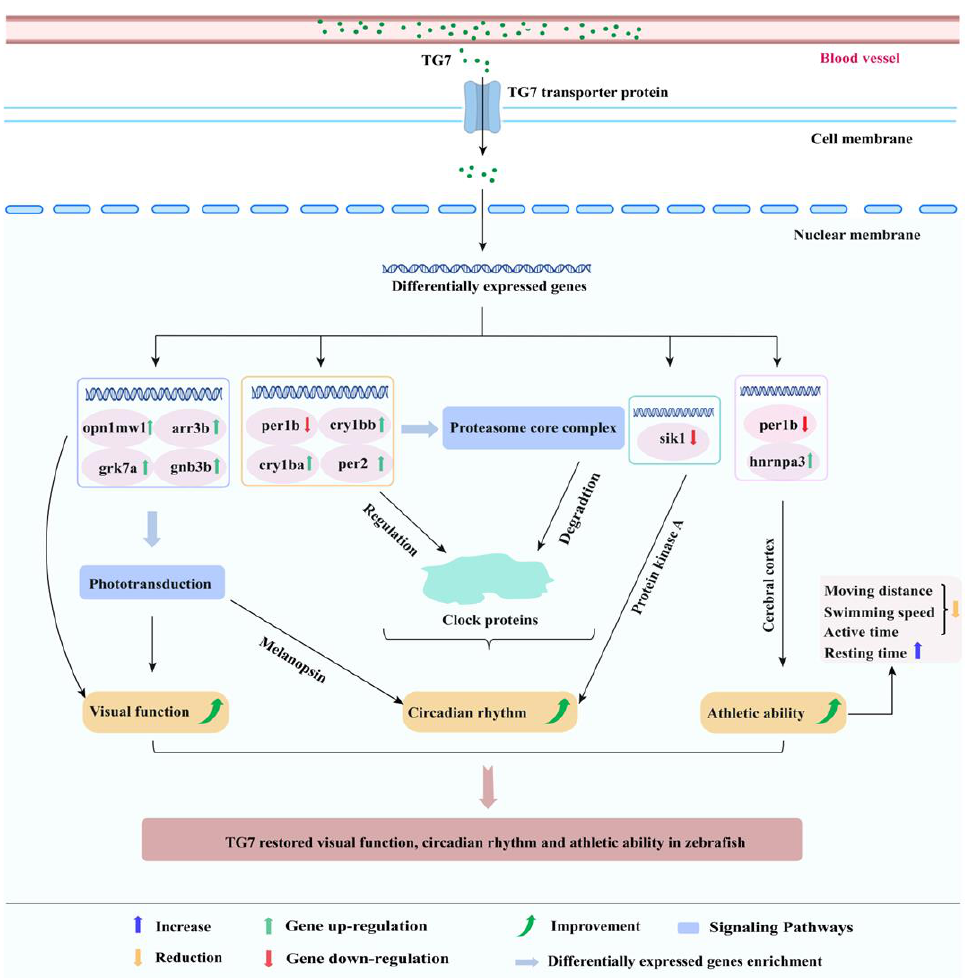
Figure 7. Sleep-promoting mechanism of TG7 on zebrafish. Tyr-Gly-Asn-Pro-Trp-Glu-Lys (TG7). By comparing the DEGs of TG7 and ICG, it can be shown that, like ICG, TG7 down- regulates per1b, while upregulating cry1bb, cry1ba and per2, which were biological clock genes associated with circadian rhythms in zebrafish [34]. Zebrafish disrupted their own circadian rhythm after prolonged light treatment, causing insomnia and metabolic disorders in the body, which led to the low expression of cry1bb, cry1ba and per2 genes in